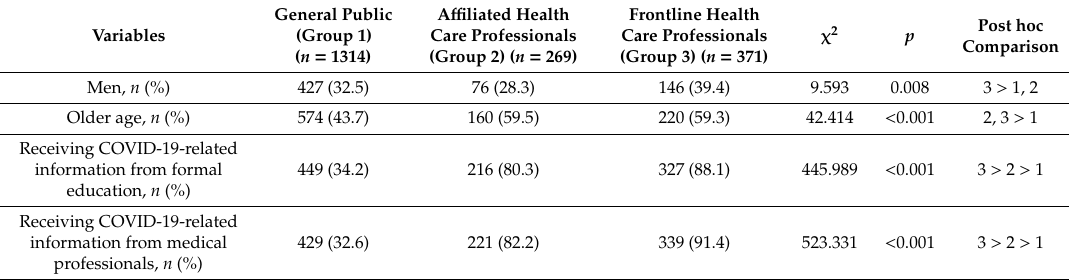
Table 1. Comparisons Between the General Public, A ffi liated Health Care Professionals, and Frontline Health Care Professionals in Taiwan, in Terms of Sex, Age, and Obtainment of Information Related to COVID-19: Chi-square